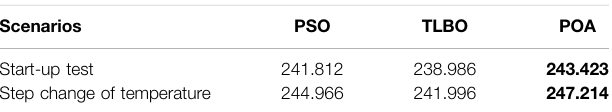
TABLE 2 | Output energy results obtained by three techniques under two scenarios (unit: Ws).